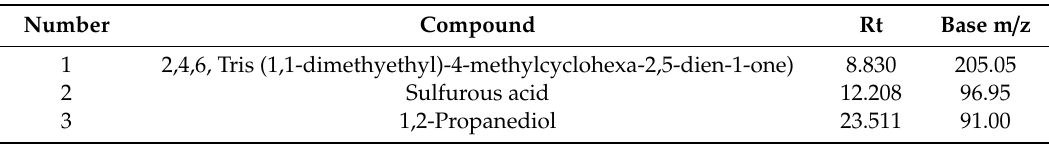
Table 4. Active preservative compounds from Acanthopora muscoides (AM) identified using GC-MS